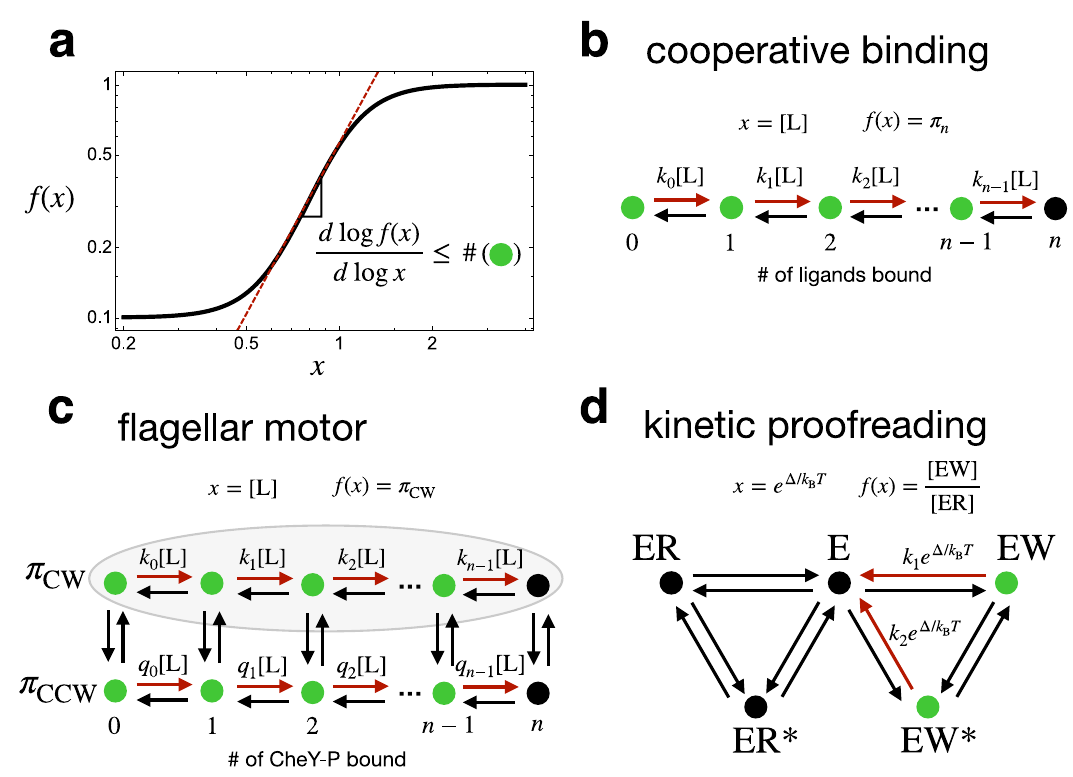
Fig. 1 | Illustration of our main result. a Example of a sensitive relationship betweenaparameter x andaquantity f ( x ).Theslopeonalog-log plotisameasure of sensitivity closely linked to the Hill coef fi cient. Our main result (inset equation) is that under general conditions this derivative is bounded by the size of the